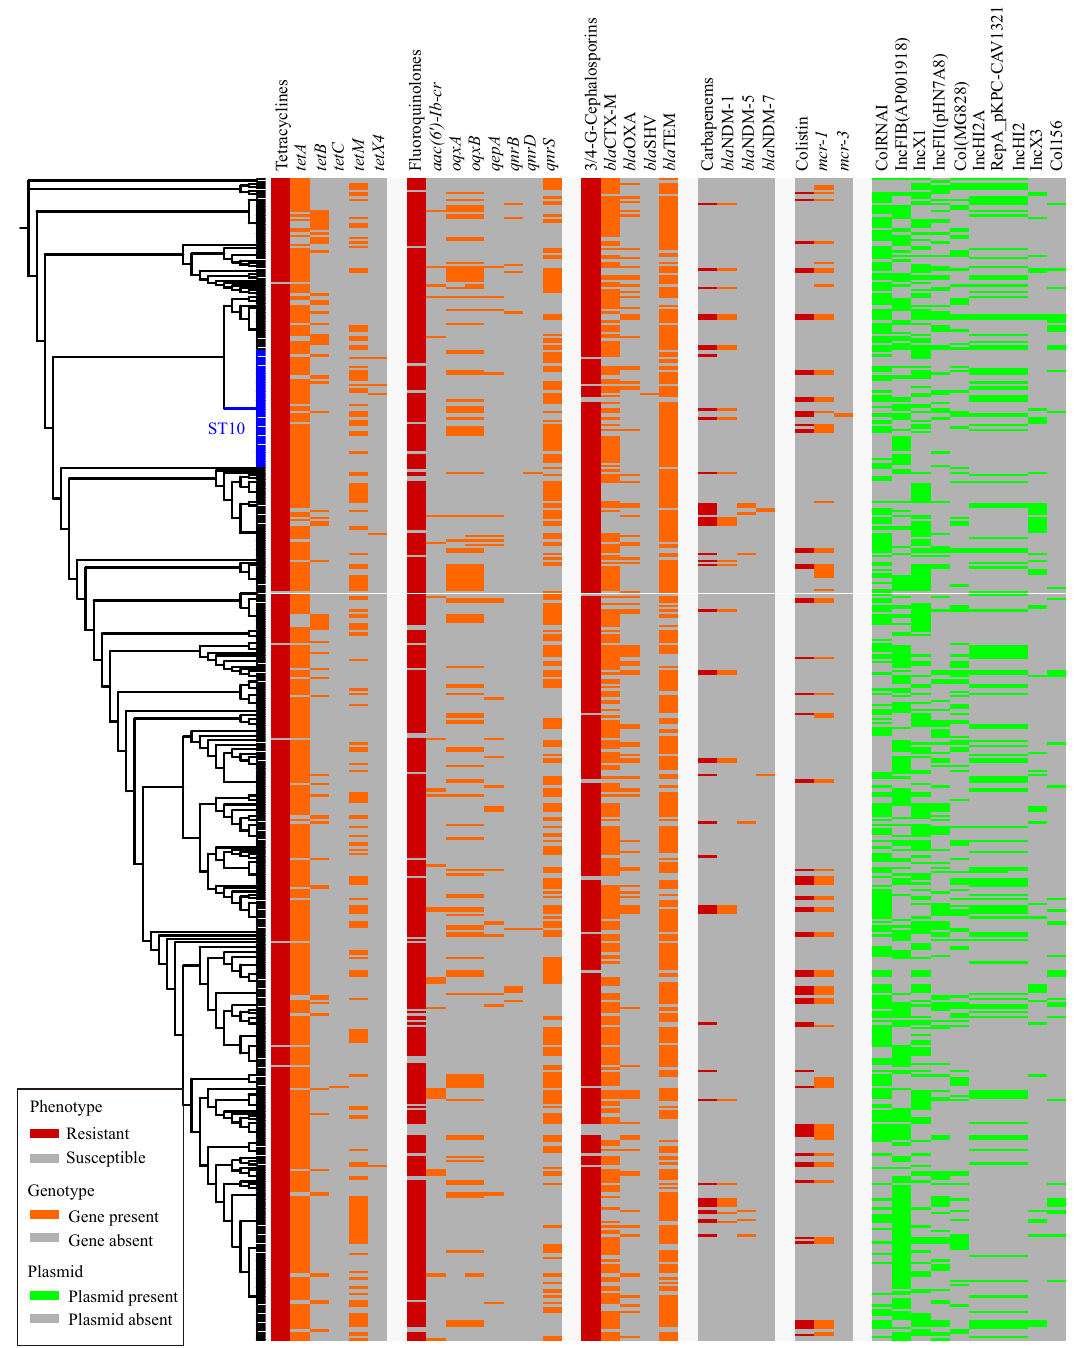
Fig. 3 Distribution of antimicrobial resistance phenotypes, antimicrobial resistance genes and plasmid replicons. The phylogenetic tree was generated based on the concatenated multilocus sequence typing (MLST) alleles using fastMLST v0.0.15, followed by multiple sequence alignment using MAFFT v7.407 and phylogenetic inference using FastTree. The tree was visualized using the Interactive Tree Of Life (iTOL v.5). Raw data for the MLST-based tree and its annotation codes are provided in Supplementary Data